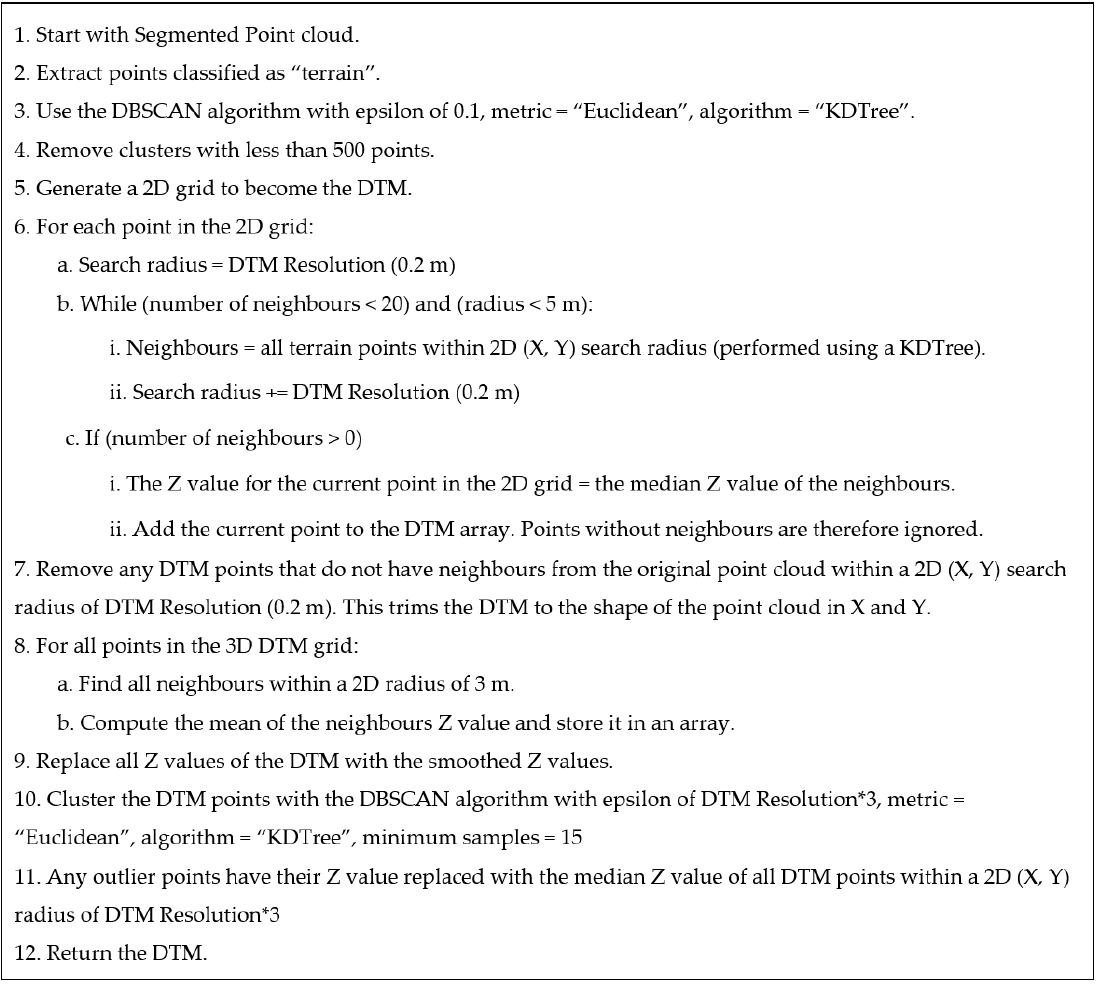
Figure 6. Pseudocode for our method of generating of a Digital Terrain Model (DTM) from a segmented terrain point cloud. DBSCAN and KDTree implementations were from [42] and [43] , respectively.